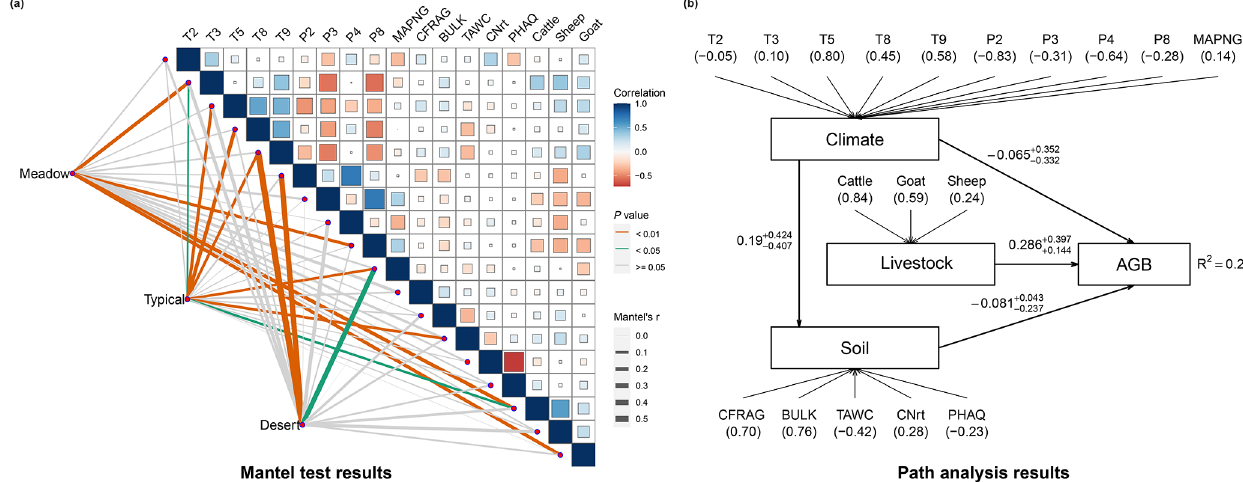
Figure 4. Environmental drivers of aboveground grassland biomass (AGB). (a) The correlation matrix of environmental drivers and Mantel test results. The upper triangle shows the pairwise comparisons of predicting variables, with a colour gradient denoting Spearman’s corre- lation coefficient. Taxonomic grassland type (i.e. meadow, typical and desert steppe) was related to each environmental factor by a partial (geographic-distance-corrected) Mantel test. Line colour represents the statistical significance, and line width denotes Mantel’s r statistic for the corresponding distance correlations. (b) The path analysis results of the direction and magnitude of the effects of latent variable climate (reflected by T2, T3, T5, T8, T9, P2, P3, P4, P8 and MAPNG), soil (using CFRAG, BULK TAWC, CNrt and PHAQ as indicators) and livestock (using cattle, goats and sheep as indicators) on AGB. Numbers in parentheses represent the loadings (correlation coefficients) of the indicators to the latent variables. See Table 1 for descriptions of each variable, and see details in the Materials and methods section for the statistical